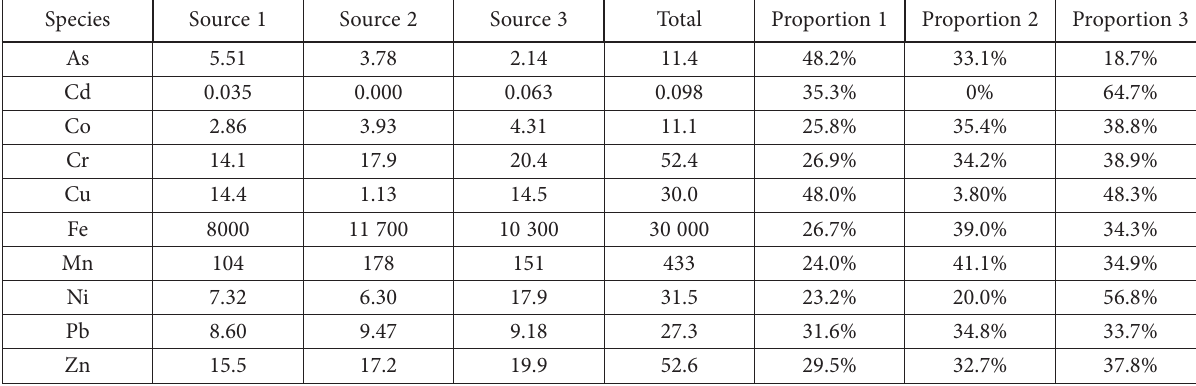
Table 4. Source profiles (mg/kg) and